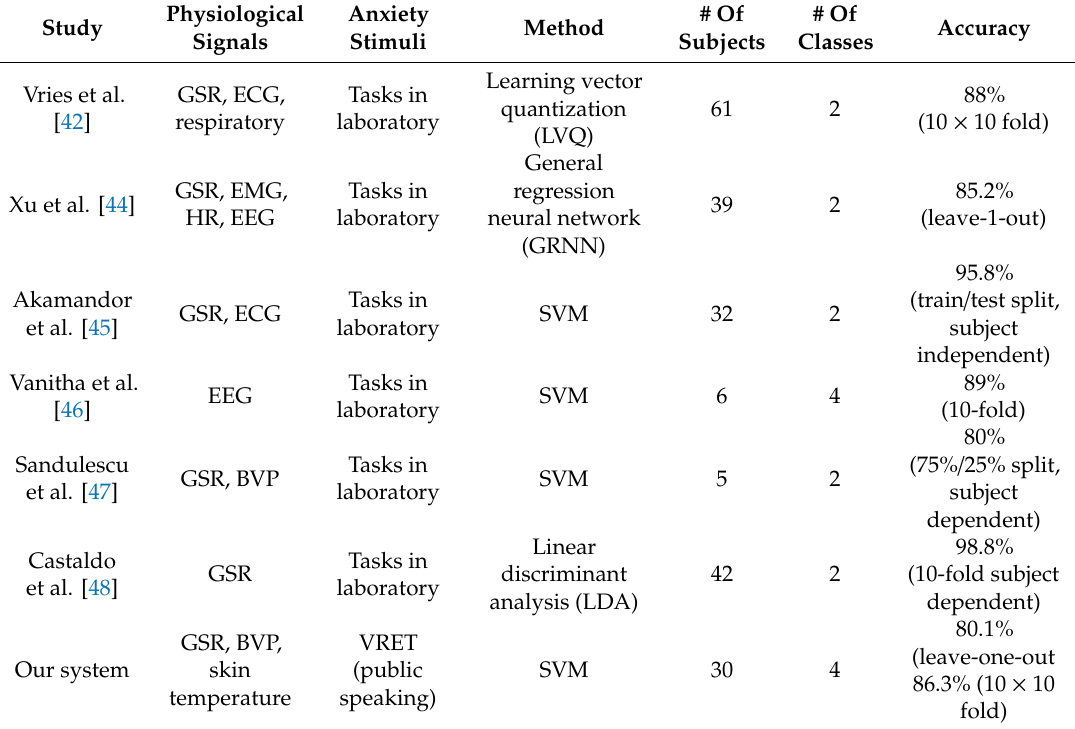
Table 4. Comparison with laboratory-induced stress recognition